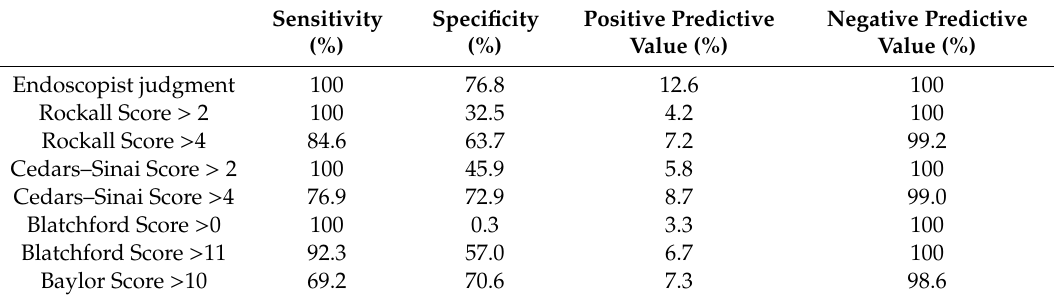
Table 2. Sensitivity, specificity and positive predictive values for mortality (all patients).